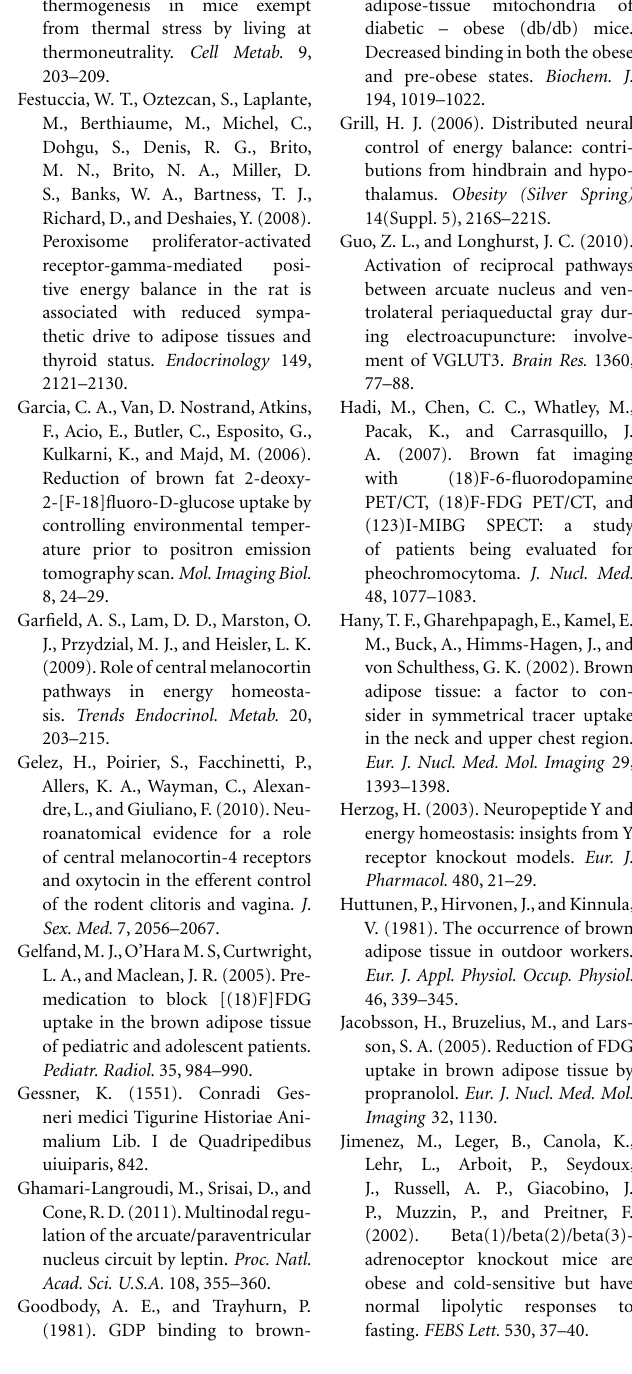
(123)I-MIBG SPECT: a study of patients being evaluated for